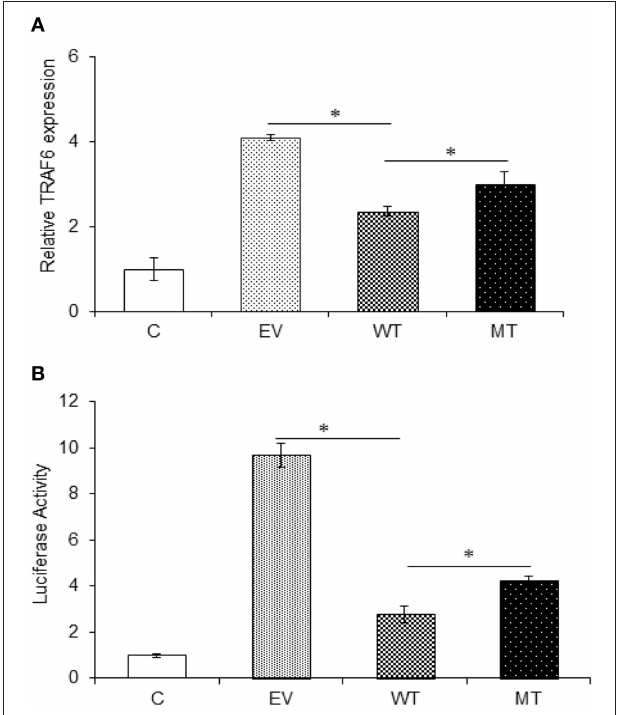
FIGURE 7 | TRAF6 expression in presence of miR-125b. A decreased TRAF6 expression was observed in the presence of miR-125b in HT29 cells. (A) For gene expression assay, miR-125b and TRAF6 were co-transfected in HT29 cells for 48h. After 48h, RNA was isolated and reverse transcribed to investigate the mRNA expression of TRAF6 through qRT-PCR. GAPDH gene was used as an internal reference. (B) For dual luciferase reporter assay, miR-125b and TRAF6 were co-transfected in HT29 cells for 24h along with pRL-TK control plasmid, which was used as internal reference. After 24h, the dual luciferase reporter assay was performed to evaluate the luciferase activity, which corresponds to TRAF6 expression. P < 0.05 were statistically significant. * p ≤ 0.05. C, untransfected control; EV, empty vector; WT, wild type; MT, mutant. Bars represent standard error of the mean